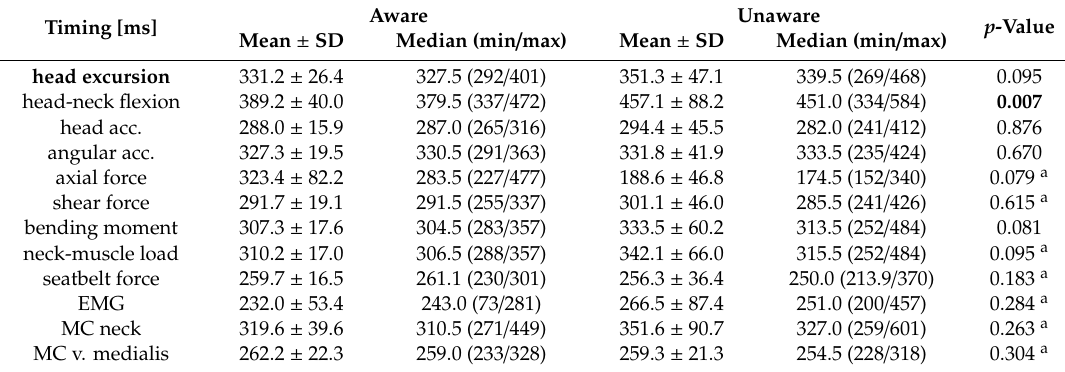
Table 2. Timing of peak values for the head-neck motion, neck loads, EMG, and MC signals for the aware and unaware trials [ms]: mean ± SD, median (min / max), and corresponding p -values for pairwise comparisons between the aware and unaware conditions.